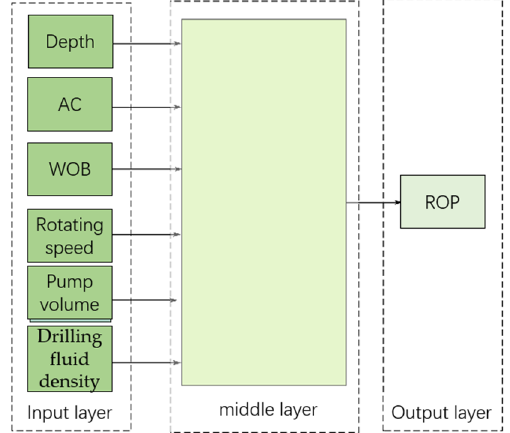
Figure 12. Input and output selection.